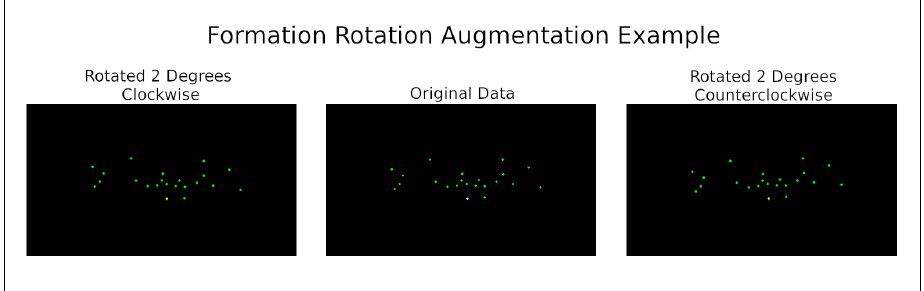
Figure 10. Formation Rotation Example—using the original data as a baseline, we rotate the players in two-degree formations (both positive and